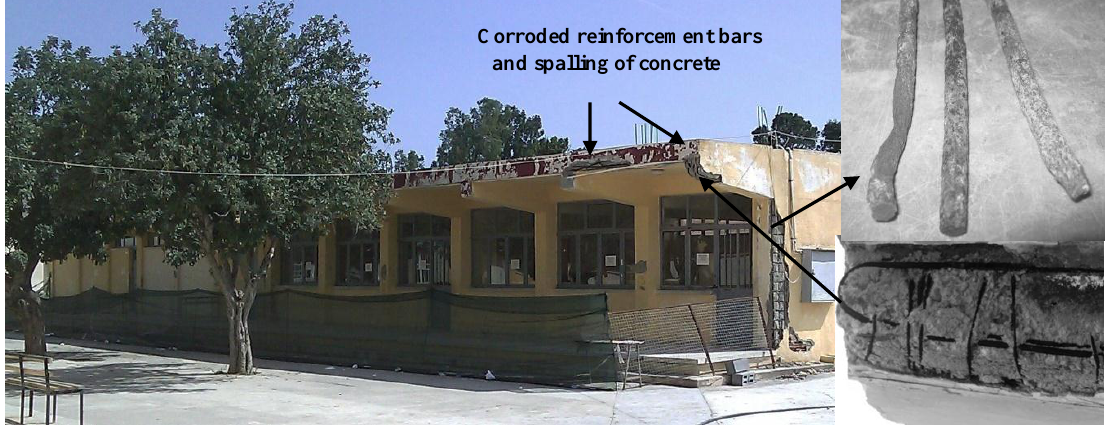
Fig. 1. Analyzed high school building.